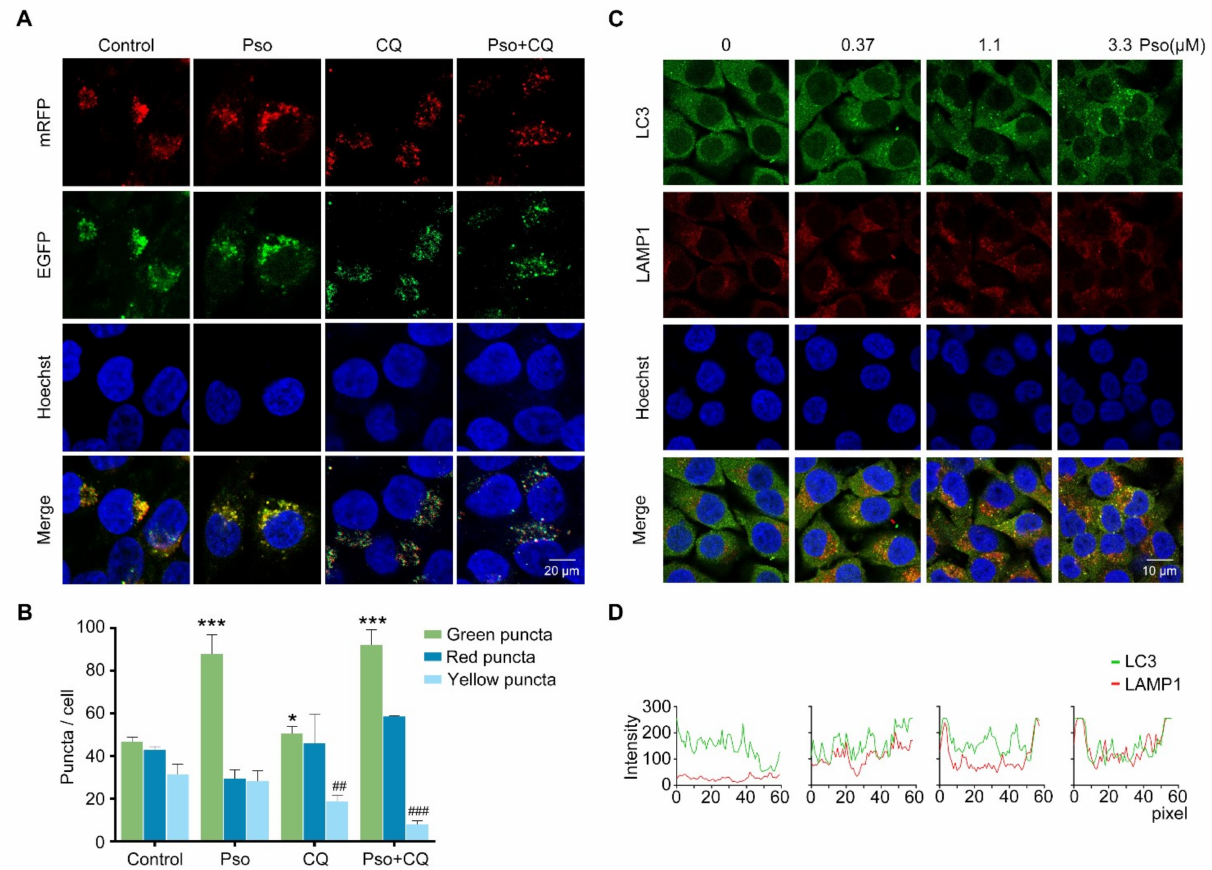
Figure 5. Psoralen promotes the autophagic flux by facilitating the fusion of the autophagosome and lysosome. ( A ) L02 cells were induced with sodium oleate (100 µ M) for 24 h, transfected with the mRFP-EGFP-LC3 plasmid, and then treated with psoralen (3.3 µ M) or CQ (10 µ M) for 24 h. Nuclei were stained with Hoechst 33258 (scale bar = 20 µ m). ( B ) Quantification of puncta per cell. ( C ) L02